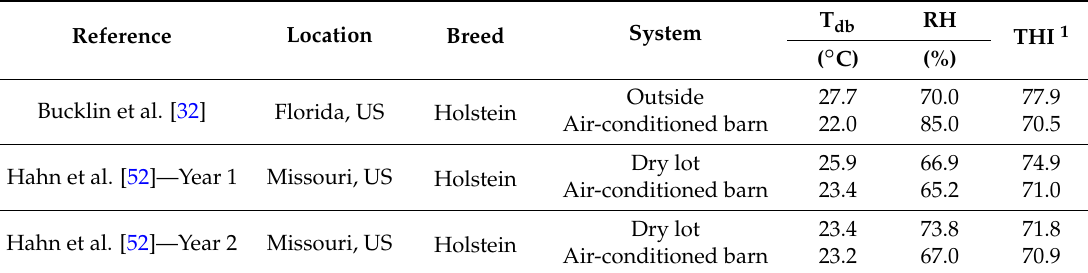
Table 3. Meteorological attributes and THI calculations for control treatments and air-conditioned dairy